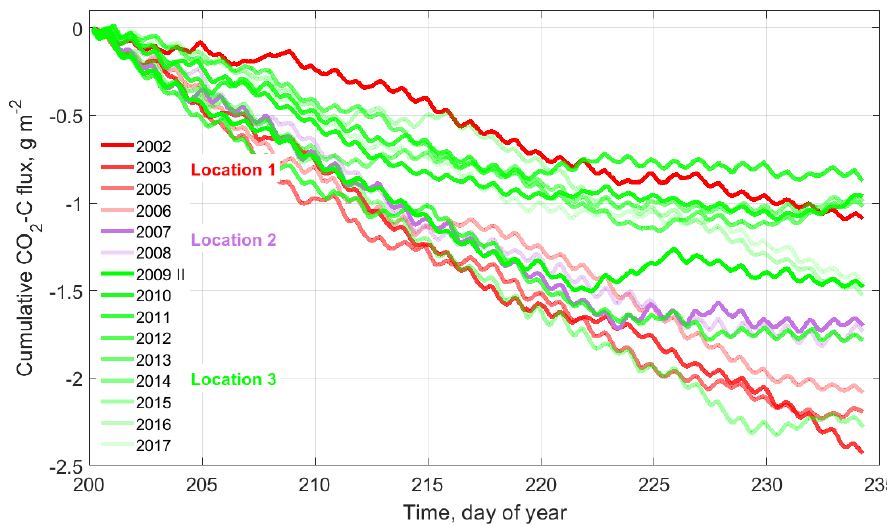
Figure 8. Comparison of cumulative CO 2 flux sums of different years during the same day-of-year range.